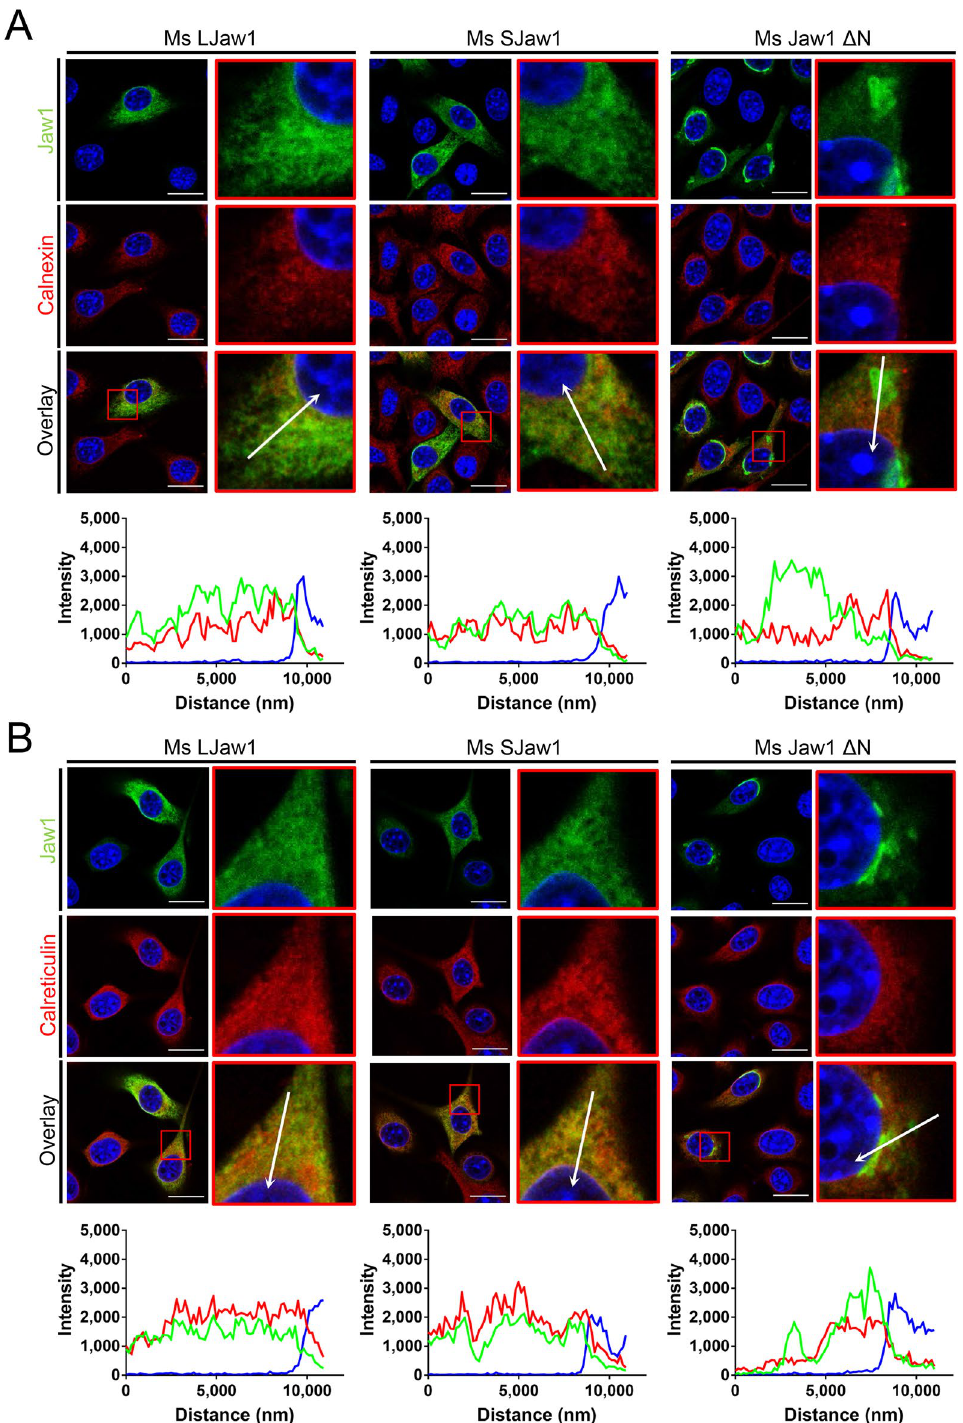
Figure 5. Evaluation of ER morphology under OSER formation. ( A , B ) Ms LJaw1, Ms SJaw1 or Ms Jaw1 ΔN were expressed in B16F10 cells by transfection. After incubation for 24 h, immunostaining was performed using an anti-Jaw1 rat antibody and an anti-calnexin rabbit antibody ( A ) or an anti-calreticulin rabbit antibody ( B ). Nuclei were stained with Hoechst33342. The images were acquired by confocal microscopy. Scale bar; 20 μm. The magnified images corresponding to the area surrounded with red lines in each image were generated and line plot profiles were performed along the arrows. Green; Jaw1, red; calnexin ( A ) or calreticulin ( B ), blue;